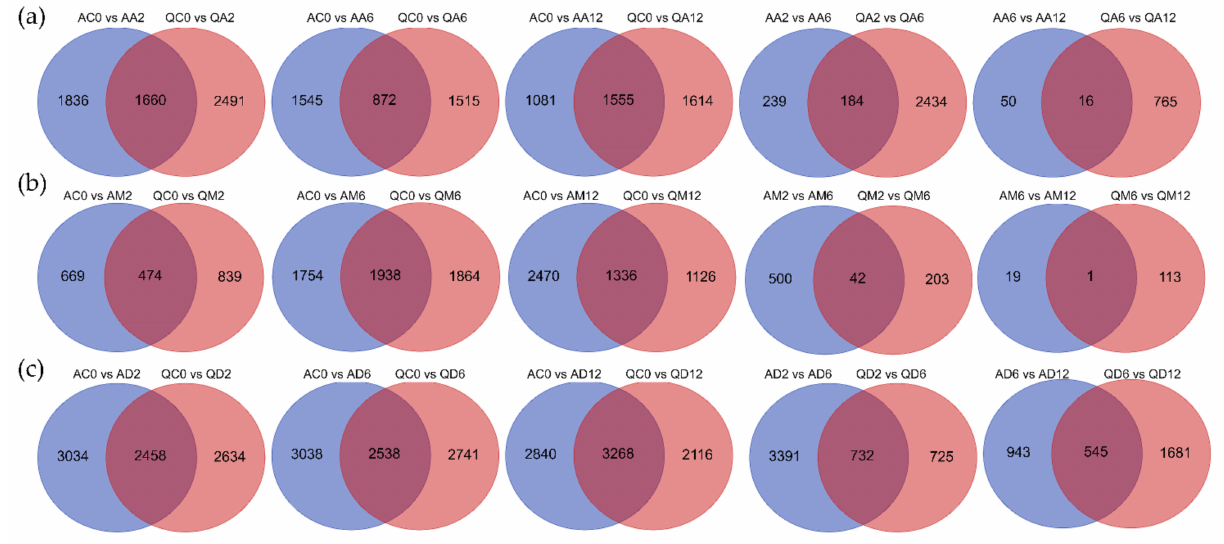
Figure 3. Venn diagram of DEGs distributed in comparisons. ( a ) Statistics of DEGs distributed in methylation inhibitor treatment between varieties A and Q. ( b ) Statistics of DEGs distributed in simulated drought treatment between varieties A and Q. ( c ) Statistics of DEGs distributed in dual treatment between varieties A and